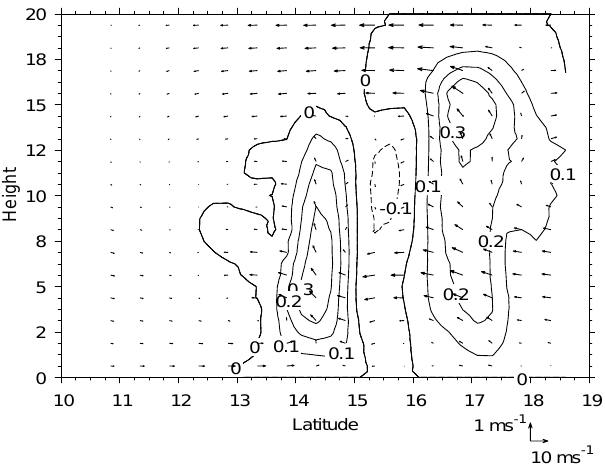
Fig. 13. Same as Fig. 12, but contours show vertical velocity every 0.1 ms − 1 .